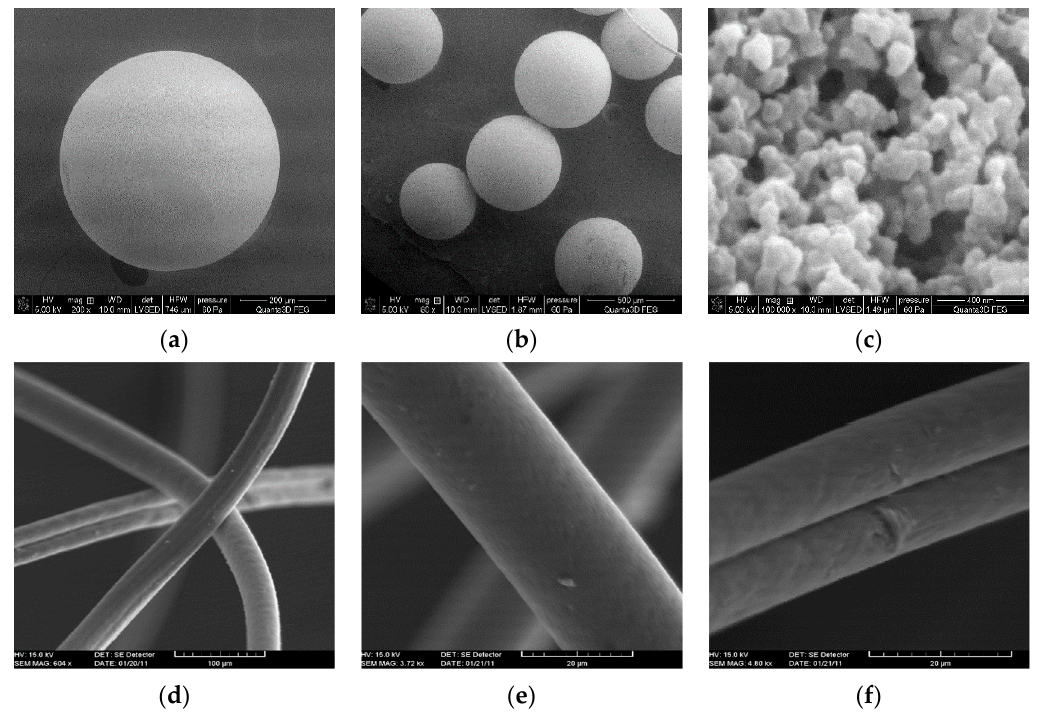
Figure 3. SEM images of Lewatit SP112 ( a – c ) and Fiban-X ( d – f ).